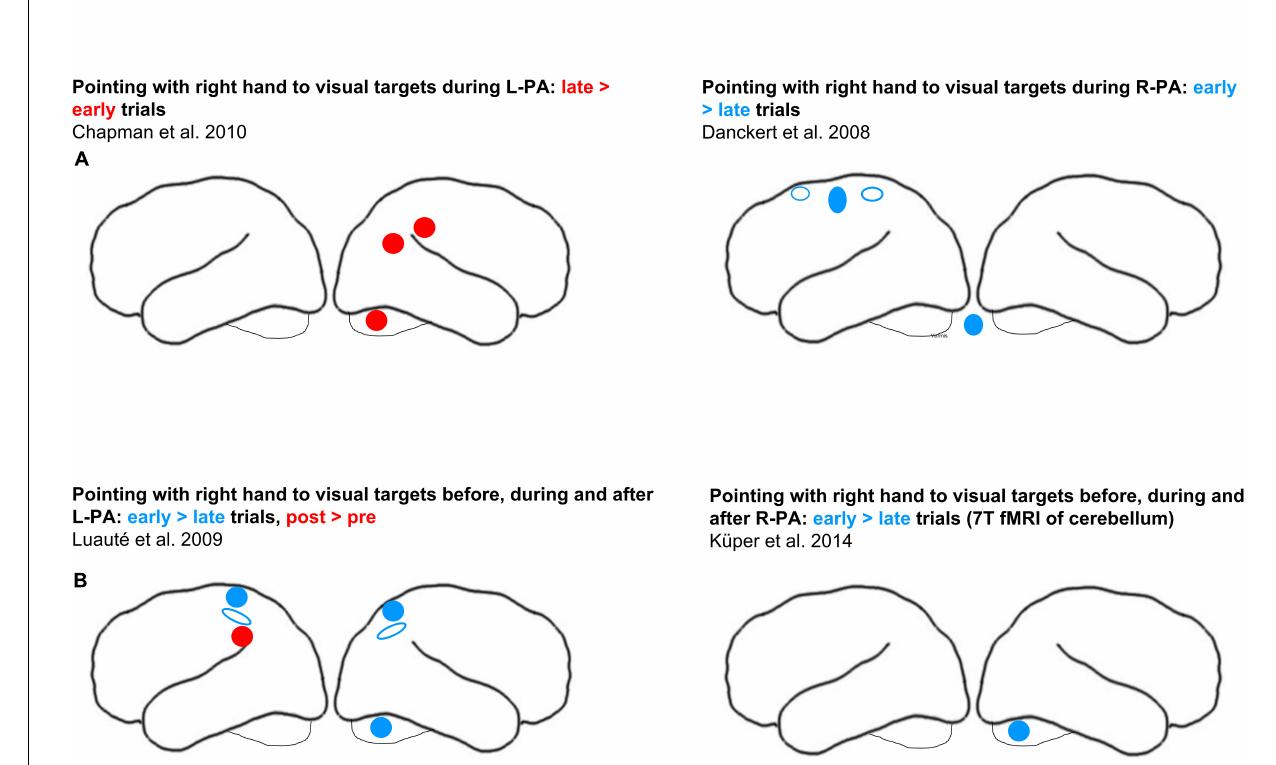
FIGURE 1 | Effects of adaptation to left-deviating (left column) and right-deviating prisms (right column), as demonstrated in normal subjects with fMRI paradigms. (A) Changes of activity elicited by pointing during prism exposure. (B) Changes of activity elicited by pointing before, during, and after adaptation. Red and blue denote, respectively, increases and decreases of activity when comparing early vs. late stages of adaptation or pre- vs. post-adaptation sessions. Filled circles and ellipses mark cluster of activity on the convexity, empty ones those in sulci or on the medial part of the